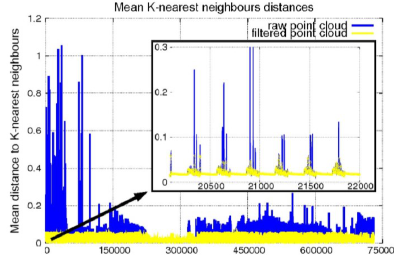
Figure 2. The mean distances to k = 30 neighbours before and after removal using α = 1 (Rusu,